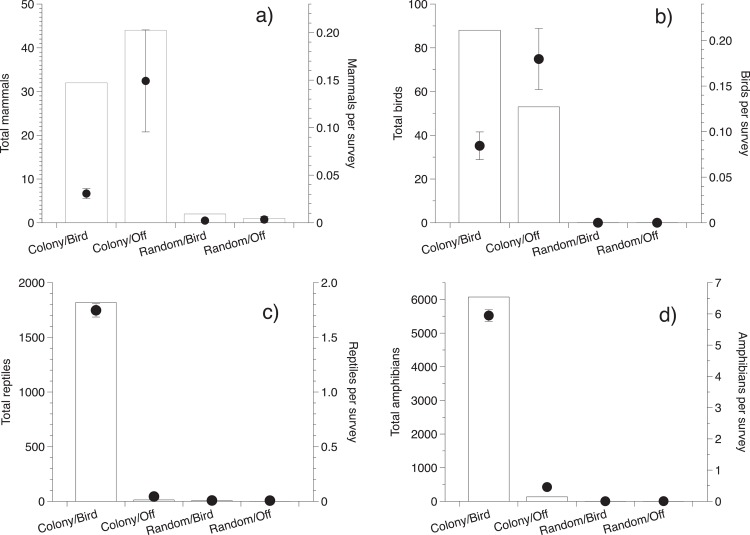
Abundance of (a) nocturnal mammals (b), birds (c) reptiles, and (d) amphibians at colony and random trees during the bird nesting season and off-season. Figures for each taxon show total number of individuals recorded (columns) and mean (±SE) values (points) of animals per survey.